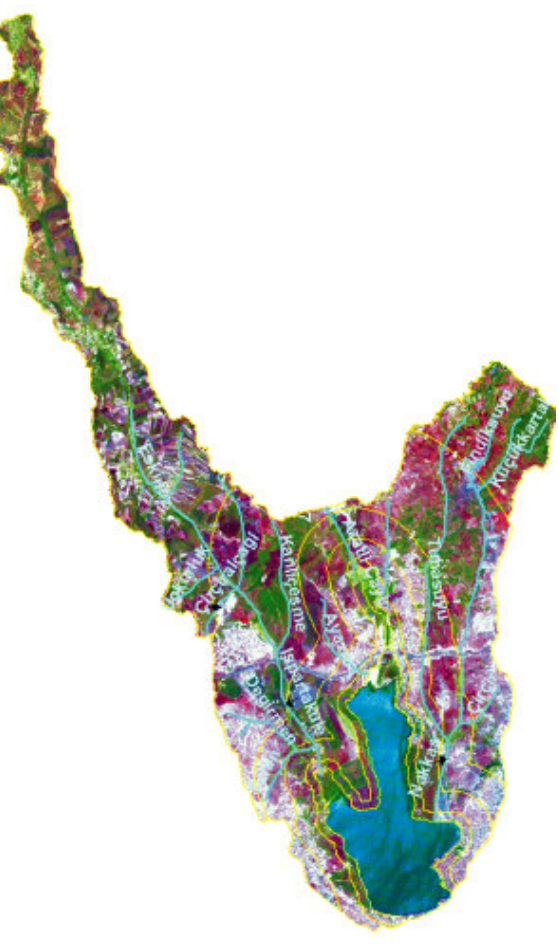
FIGURE 2 . A Landsat-5 TM + SPOT-Pan color composite satellite image of Küçükçekmece Water Basin dated 1992. Streams and protection zones were overlaid as vector data, applying GIS